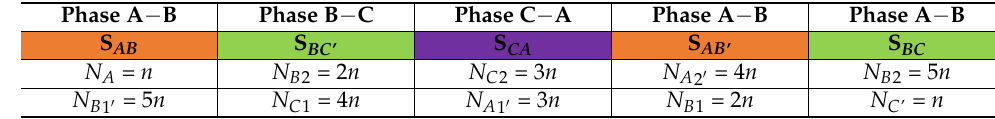
Table 7. Coil turn allocation of common slots for UOSW type A .